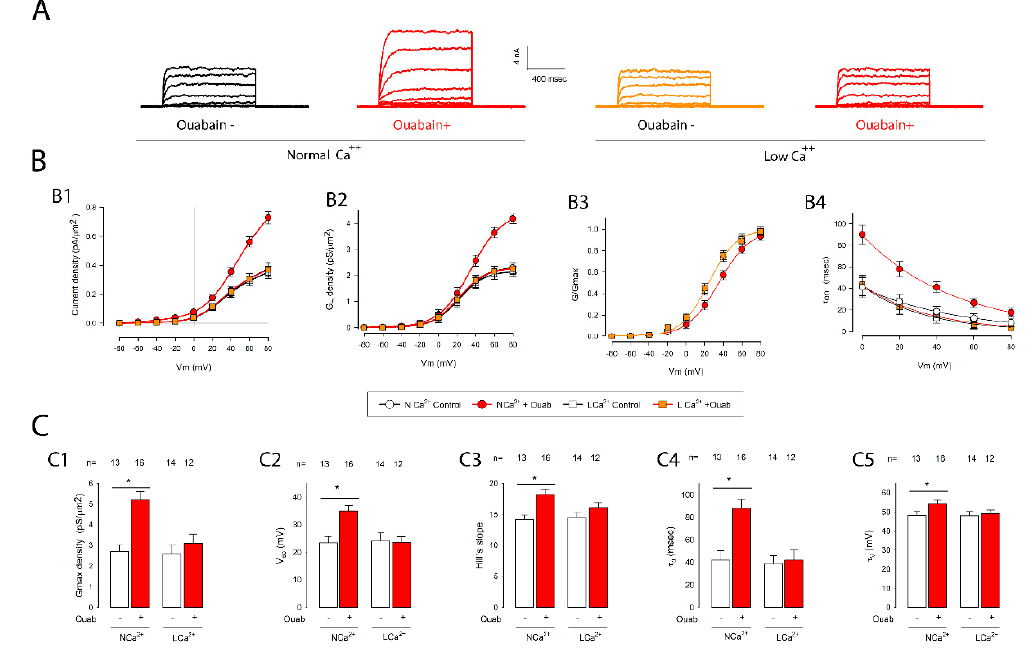
Figure 5. In the absence of extracellular calcium, ouabain had no effect on the potassium currents of cells in MEMs. ( A ) Series of currents representative of the different experimental conditions. The pair of series on the left side were obtained from cells in a mature monolayer, which had been either untreated or treated with ouabain for 6 hours. The pair of series on the right side was obtained from cells in mature monolayers from which calcium had been removed from the extracellular medium before treatment with ouabain. ( B ) The graphs ( B1 – B4 ) show the relationship between the different parameters (current density, conductance density, g/gmax and tau on ) and the transmembrane voltage for the different experimental groups (with and without calcium, and with and without ouabain). The symbols for each group are shown in the box located below ( B2 , B3 ). ( C ) The bar charts ( C1 – C5 ) show the average values ( ± SE) obtained in each experimental group as well as the result of the statistical comparison between them. The numbers above the bars indicate the number of repetitions in each group. The asterisks above the horizontal lines denote a statistically significant difference between the means (±SE) of treated versus untreated cells; (*) indicates a p < 0.05.